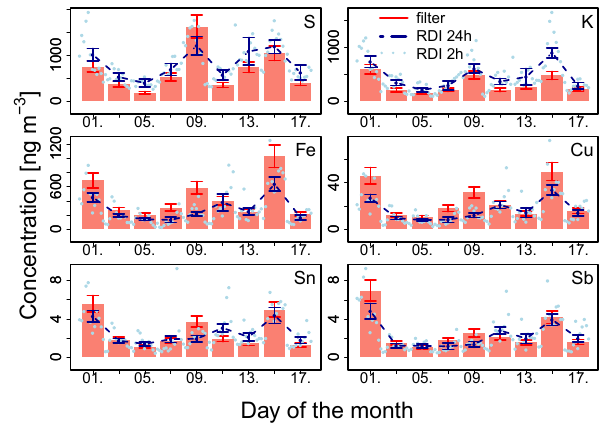
Fig. 11. Comparison of time series of 2-h RDI values to daily high- volume filter samples. PM 10 filter values are compared to the sum of all RDI stages from Z ¨ urich winter campaign for typical elements S, K, Fe, Cu, Sn and Sb. The 2-h RDI data are shown in light blue, the 12 corresponding RDI values binned to 24-h values are shown in dark blue and the 24-h filter values are shown as red bar plots. Filter samples were taken every other day on 1, 3, 5, 7, 9, 11, 13, 15 and 17 December 2008.